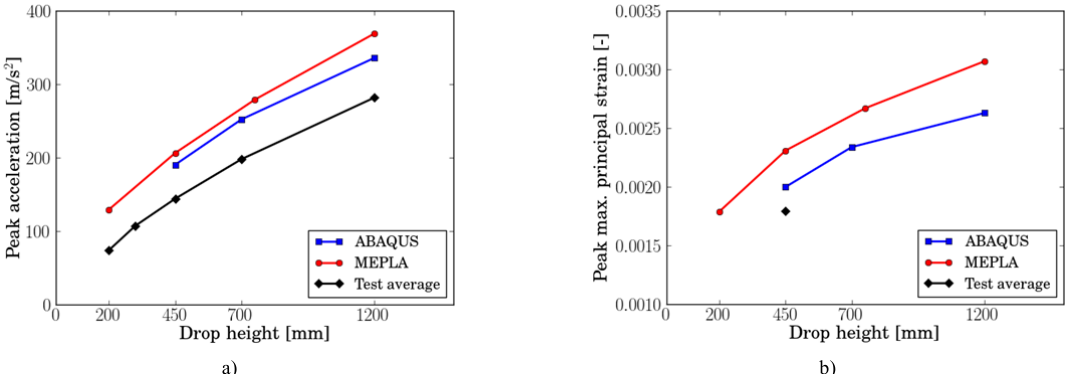
Fig. 12 Peak values for response of laminated glass upon pendulum impact at various drop heights: a) Acceleration and b)